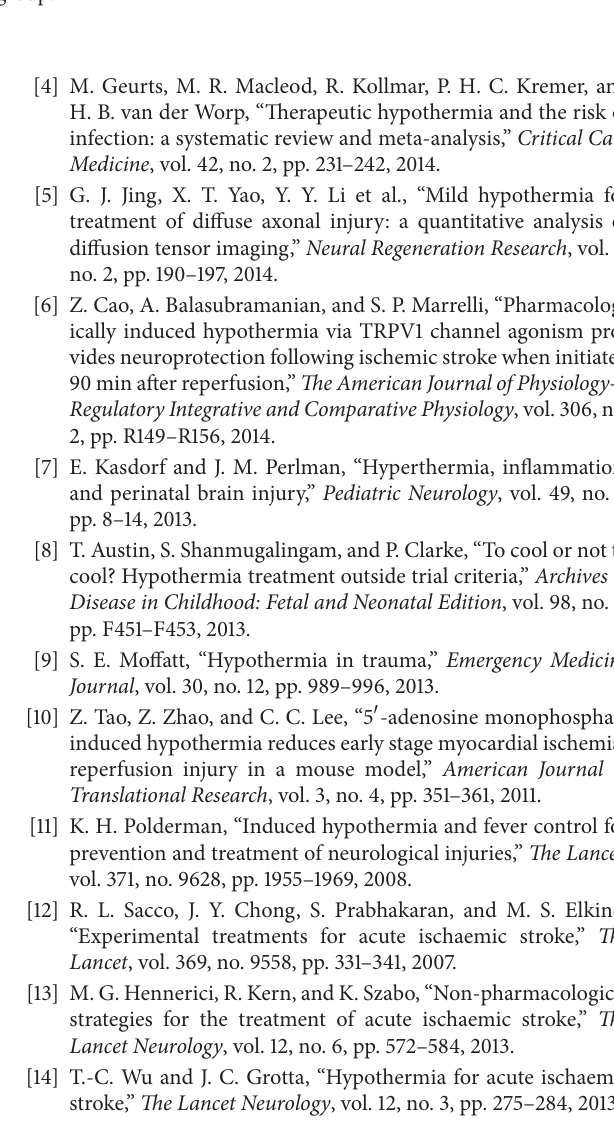
Figure 6: AIH reduces MMP-9, IL-1R, TNFR, and TLR protein levels in the infarcted brain. (a) Western blot analysis of protein expression of MMP-9, IL-1R, TNFR, and TLR in the sham, MCAO, NT, HT(1.0), and HT(0.5) groups. 𝛽 -Actin was used as an internal reference. (b) Optical density analysis of MMP-9, IL-1R, TNFR, and TLR. All values are the mean ± SEM. ∗ 𝑃 < 0.05 compared to the MCAO group, # 𝑃 < 0.05 compared to the NT group, and & 𝑃 < 0.05 compared to the HT(0.5)